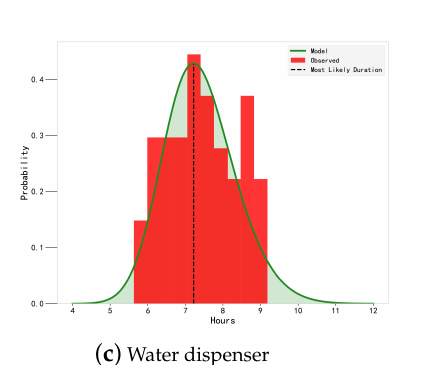
Figure 9. Energy use working hours model of electrical